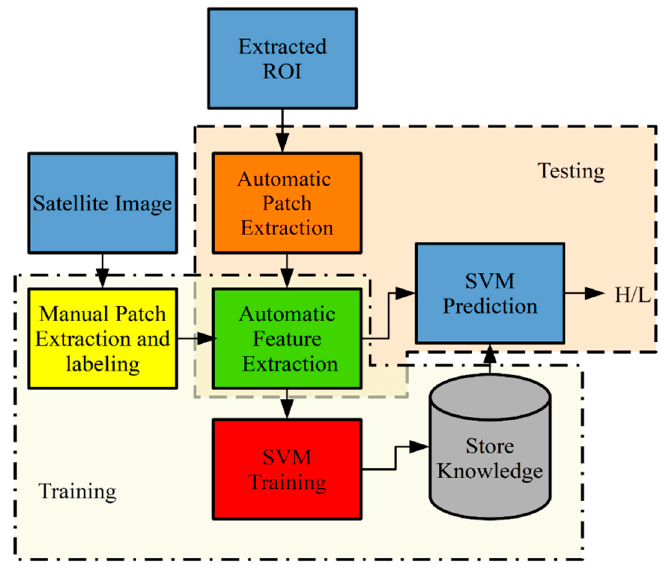
Figure 3. Proposed vegetation encroachment detection method comprising of two stages: training and testing. and